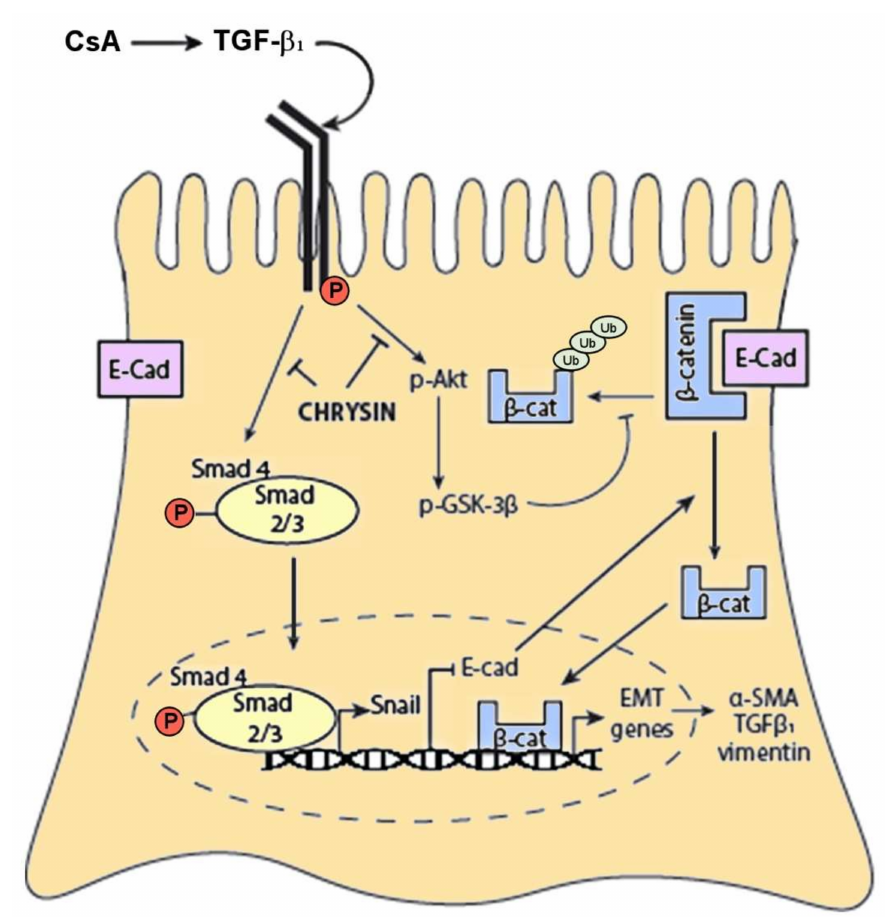
Figure 8. Mechanism of action of chrysin against TGF- β 1-mediated EMT signaling chrysin inhibits CsA-induced TGF- β 1/Smad-dependent increase in Snail expression, preventing a decrease in E- cadherin expression and subsequent localization of β -catenin into the cytoplasm. Chrysin also inhibits Akt/GSK-3 β -mediated signaling, inducing the degradation of cytosolic β -catenin. Action on both of these pathways prevents cytosolic accumulation of β -catenin thereby inhibiting EMT and preventing the development and progression of